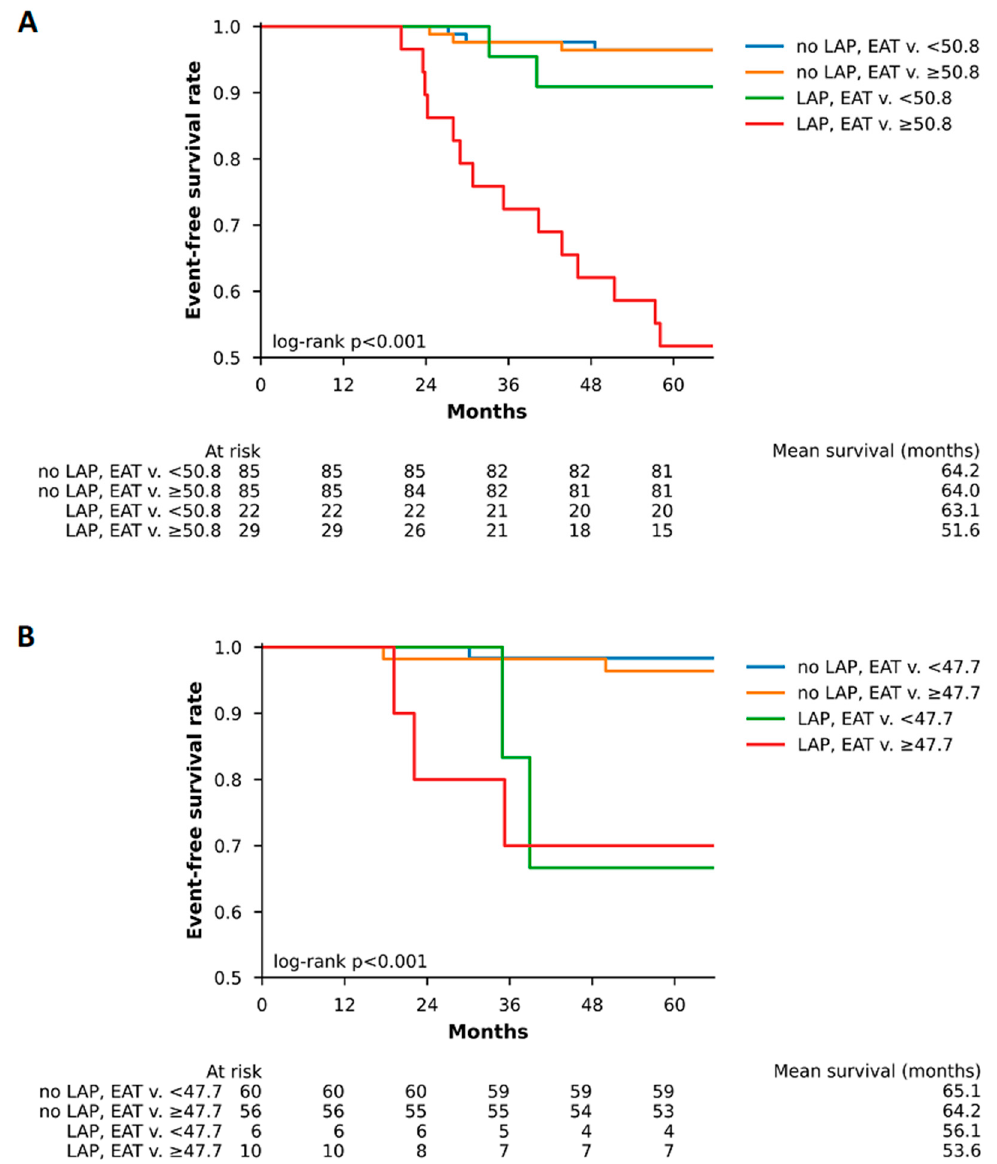
Figure 2. Kaplan–Meier curves in men and women according to the presence of low-attenuation plaque and EAT volume. Kaplan–Meier curves stratified by a combination of the presence of low- attenuation plaque and EAT volume in ( A ) men and ( B ) women. EAT = epicardial adipose tissue, LAP = low-attenuation plaque.